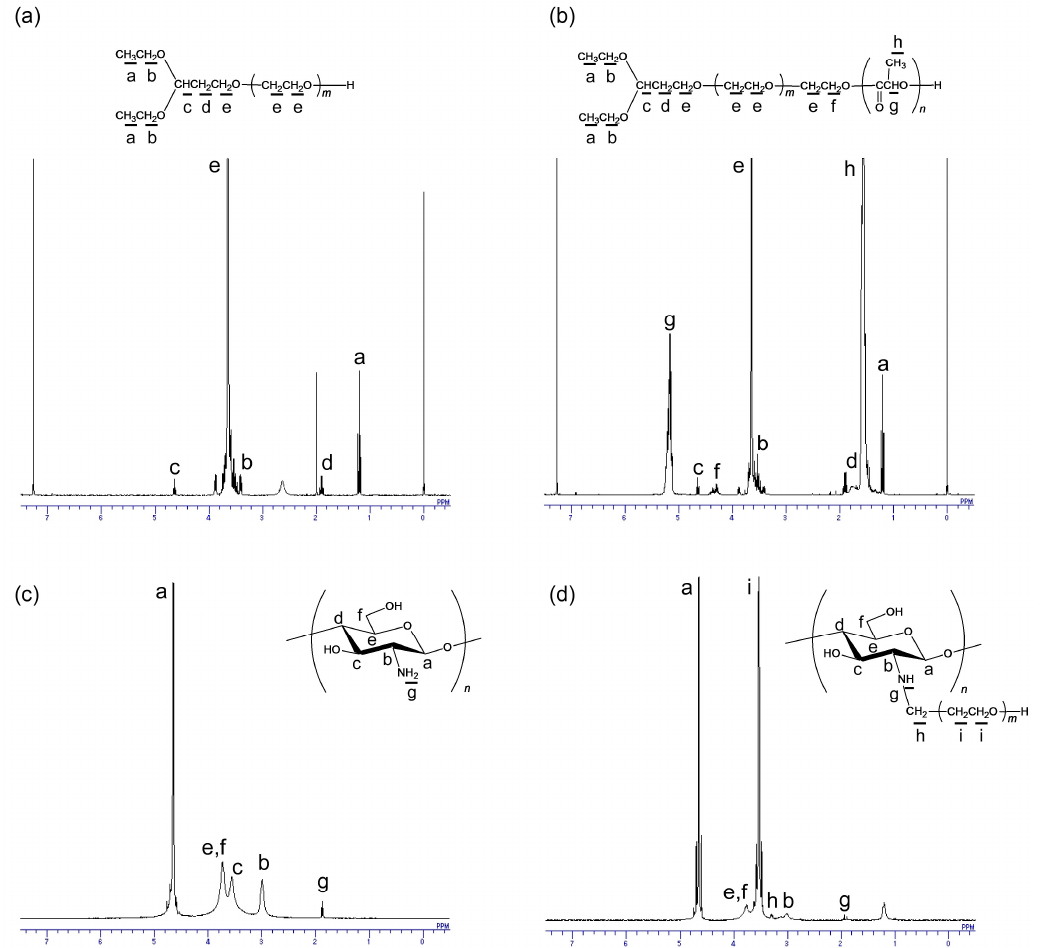
Figure 3. 1 H NMR spectra of ( a ) acetal-PEG; ( b ) acetal-PEG- b -PLA; ( c ) chitosan; and ( d ) PEG-grafted chitosan.